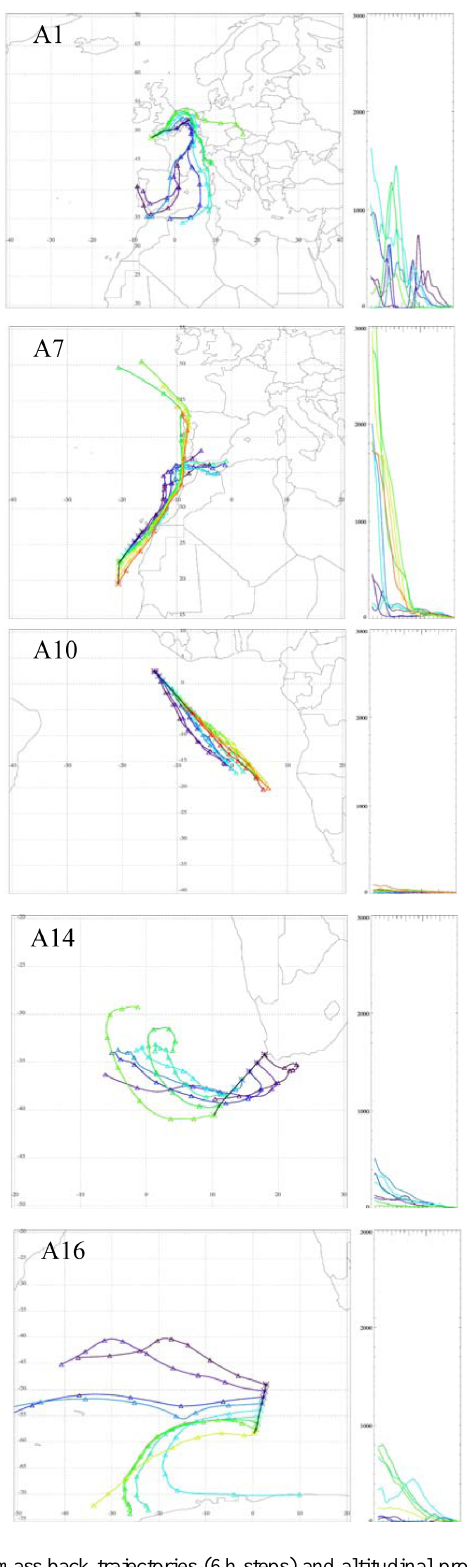
Fig. 2. 96h air mass back trajectories (6h steps) and altitudinal profiles of the air mass parcels for the cruises ANT-XXV/1+2 (A1–A17). For samples longer than 72h, only every second BT was plotted. The black line indicates the cruise